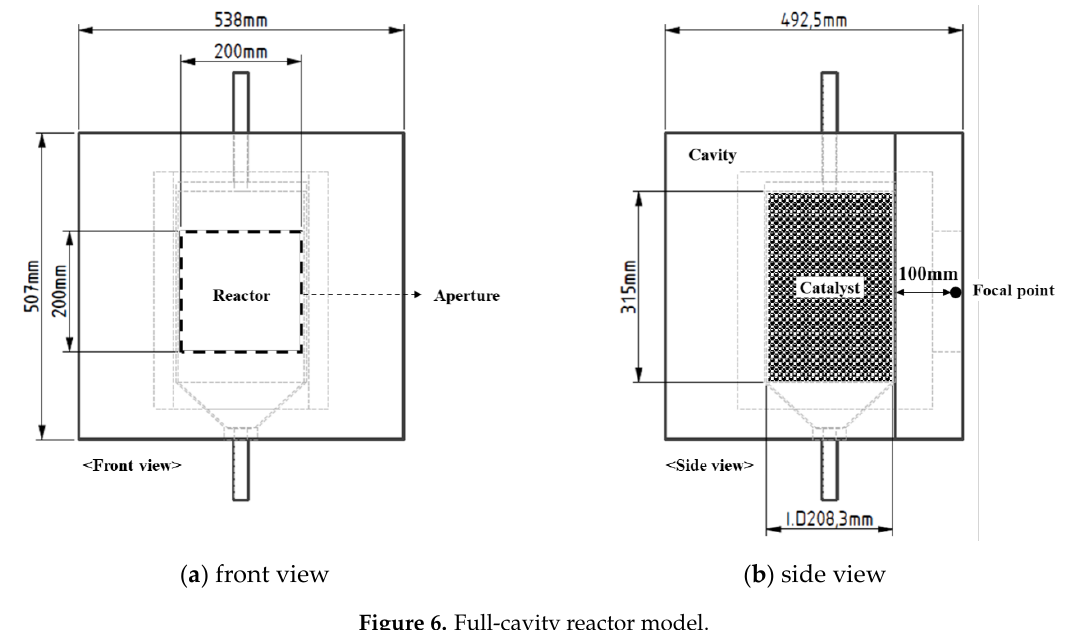
Figure 6. Full-cavity reactor model.